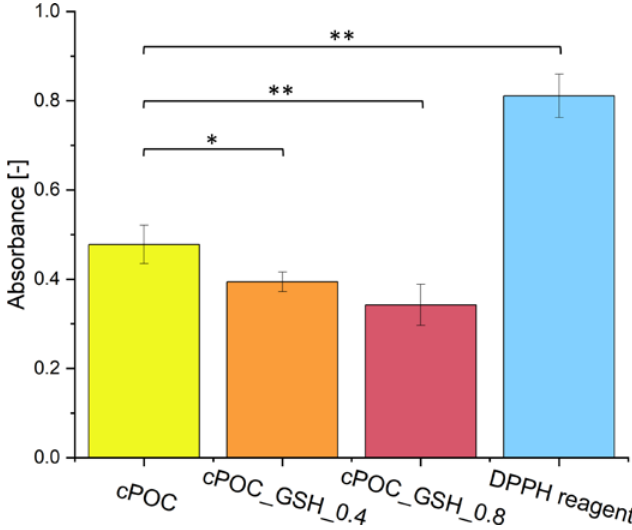
Figure 4. DPPH• free radical scavenging assay results for cPOC, cPOC_GSH_0.4 and Figure 4. DPPH • free radical scavenging assay results for cPOC, cPOC_GSH_0.4 and cPOC_GSH_0.8. cPOC_GSH_0.8. The absorbance value of the DPPH r eagent served as a control sample. Mean ± SD, The absorbance value of the DPPH reagent served as a control sample. Mean ± SD, statistically statistically significant differences at * p < 0.01 and ** p < 0.001. significant differences at * p < 0.01 and ** p <